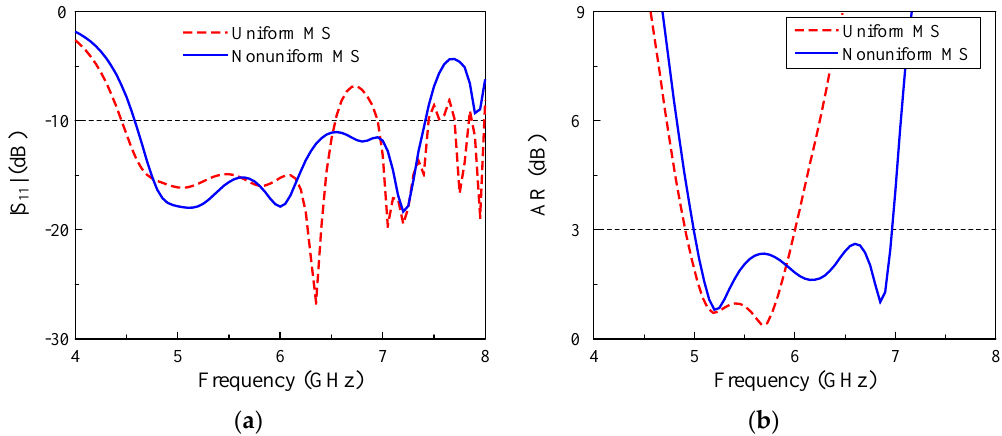
Figure 5. Simulated ( a ) |S 11 | and ( b ) AR for the antenna using a uniform MS and non-uniform MS.